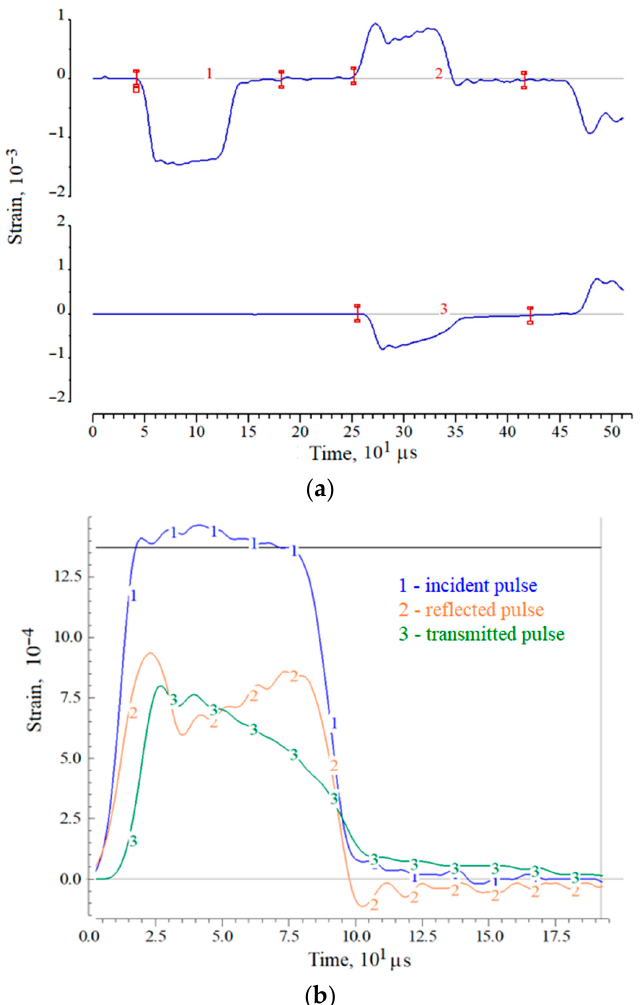
Figure 3. An example of strain pulses in measuring bars during registration ( a ) and during synchronization ( b ) when testing a ceramic specimen with its complete destruction.